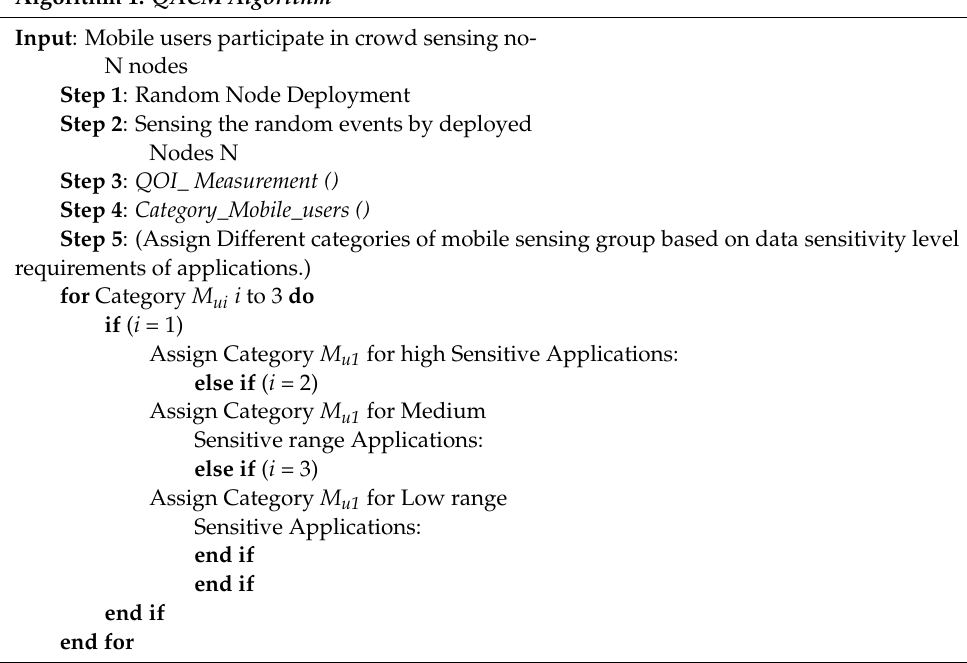
Algorithm 1: QACM Algorithm